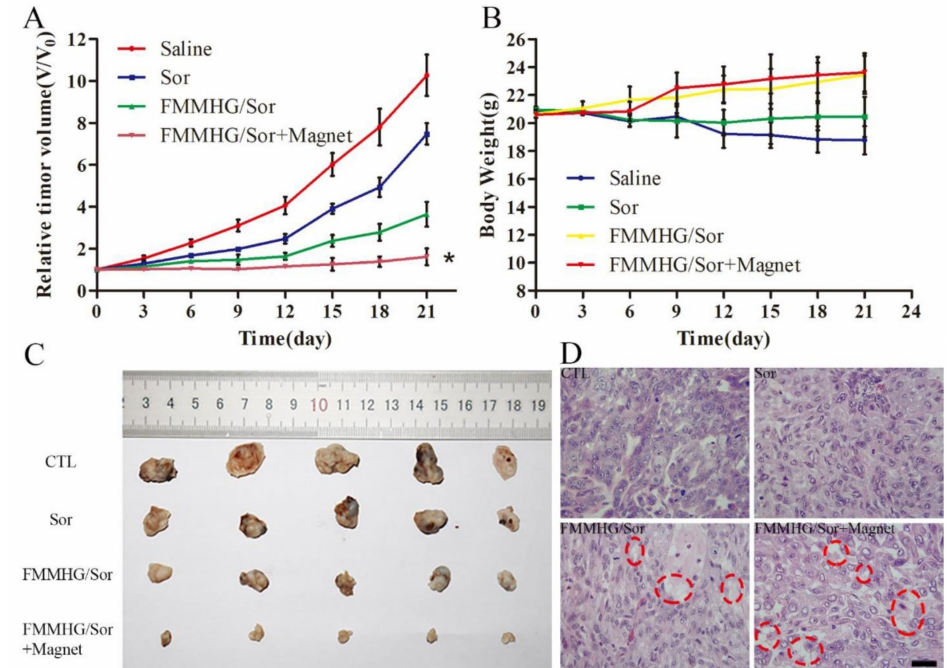
Figure 14. In vivo antitumor therapeutic effect of FMMHG/Sor. ( A ) The tumor volume of mice after being treated with saline, free Sor, FMMHG/Sor, and FMMHG/Sor + magnet for 21 days. * p < 0.05. ( B ) The body weight of mice in each group (saline, free Sor, FMMHG, and FMMHG + magnet) with treatment for 21 days. ( C ) Representative photos of tumor tissues obtained in different groups (saline, free Sor, FMMHG, and FMMHG + magnet) after 21 days of treatment. ( D ) Histological section of tumor tissues with H&E staining of different groups (saline, free Sor, FMMHG, and FMMHG + magnet) after 21 days of treatment. The fat vacuoles were marked with a red circle, which was the sign of ferroptosis. Scale bars, 100 µ m. Reprinted from [114] with permission of Elsevier provided by Copyright Clearance